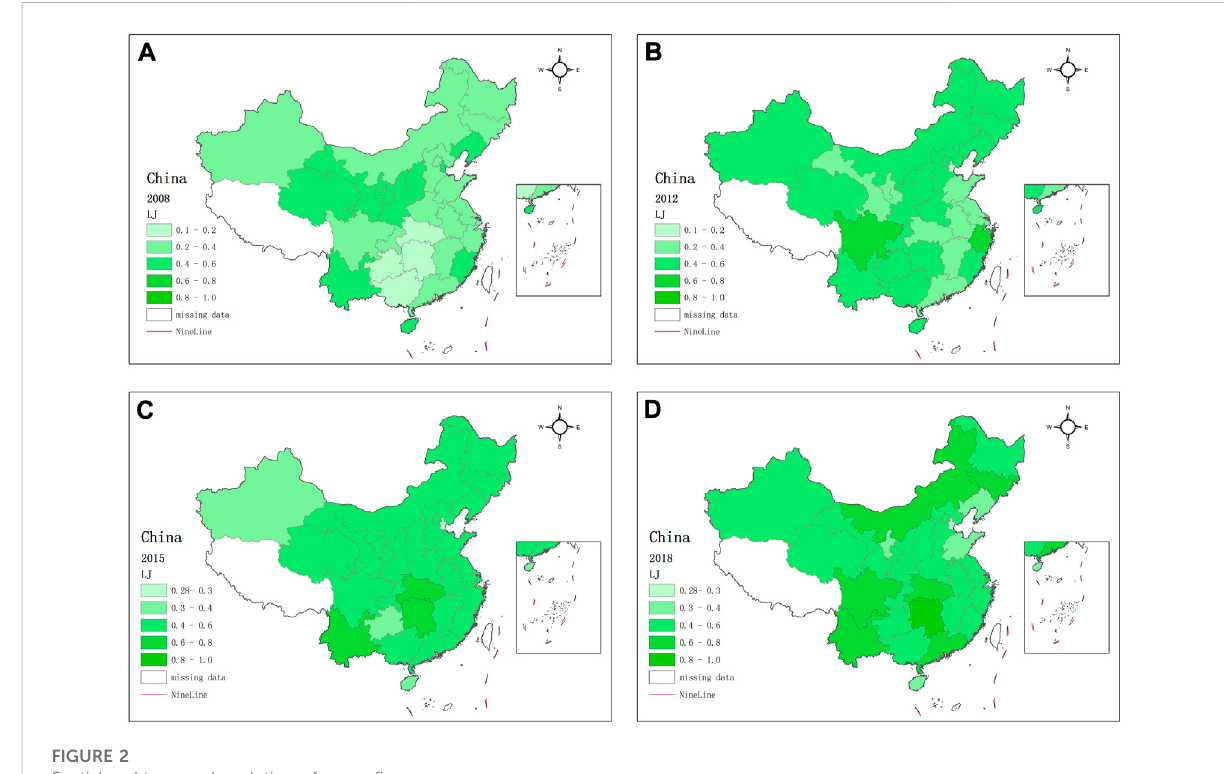
FIGURE 2 Spatial and temporal evolution of green fi nance.